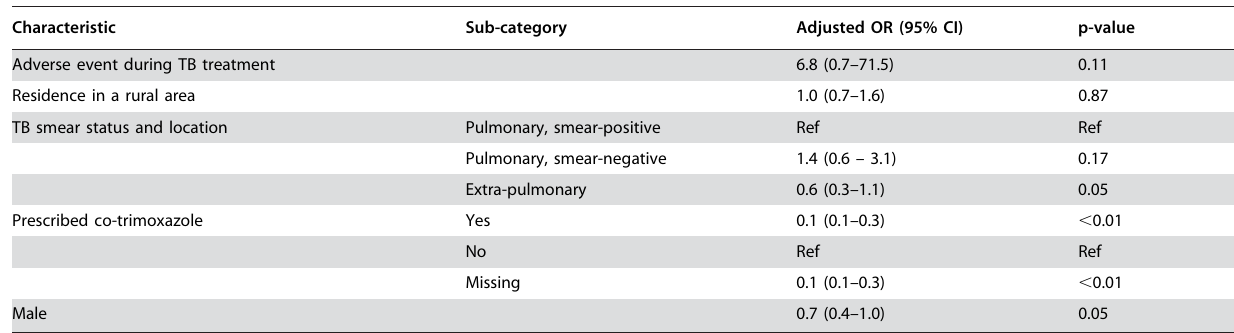
Table 4. Multivariate analysis of risk factors for unsuccessful TB treatment outcomes among HIV-infected TB patients – An